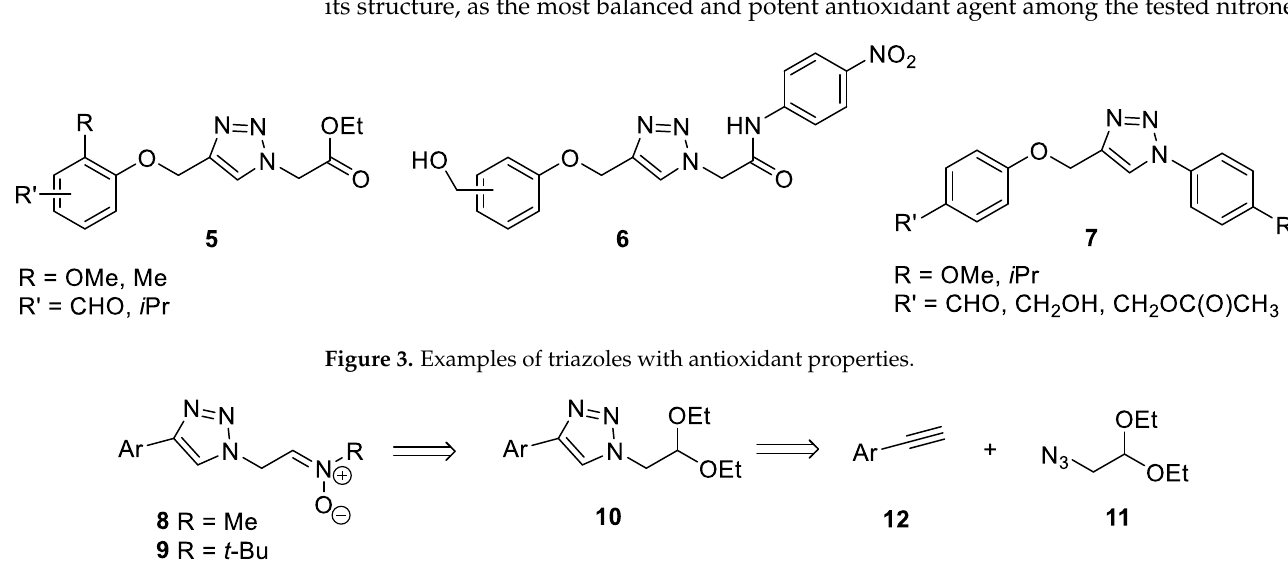
Figure 3. Examples of triazoles with antioxidant